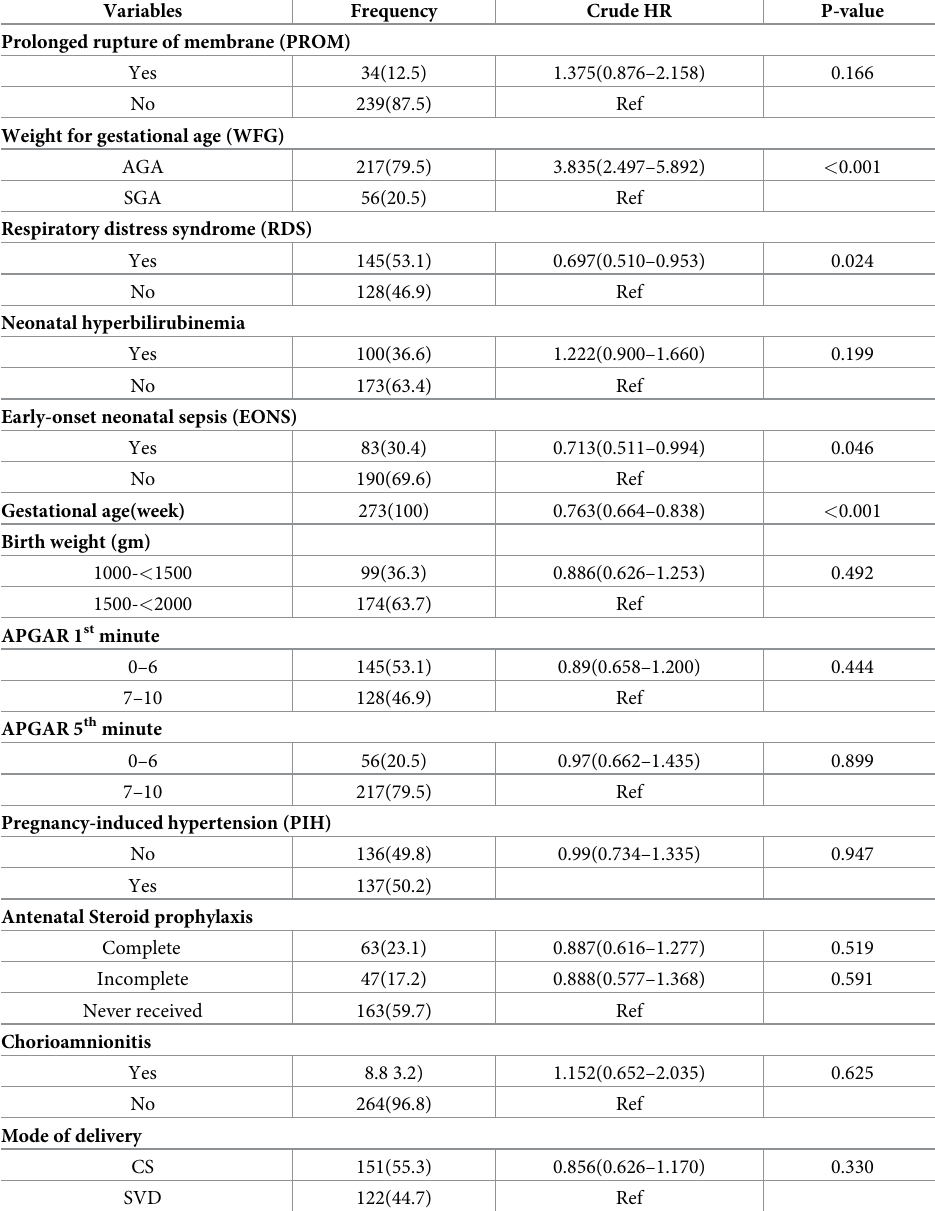
Table 3. Bivariate Cox-regression analysis of associated factors of full enteral feeding achievement of LBW neo- nates admitted to the neonatal ICU in Hawassa city, Sidama region Ethiopia, 2019. Variables Frequency Crude HR